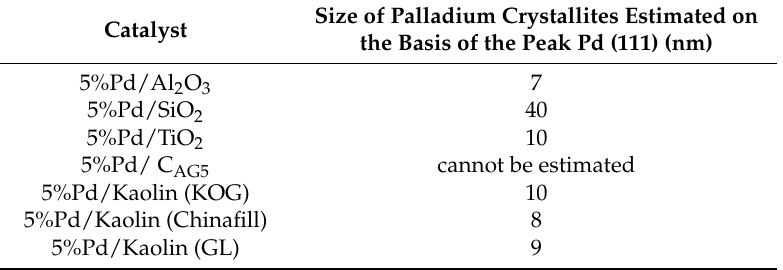
Table 11. Size of palladium crystallites estimated on the basis of XRD results using the Scherrer equation. Size of Palladium Crystallites Estimated Catalyst